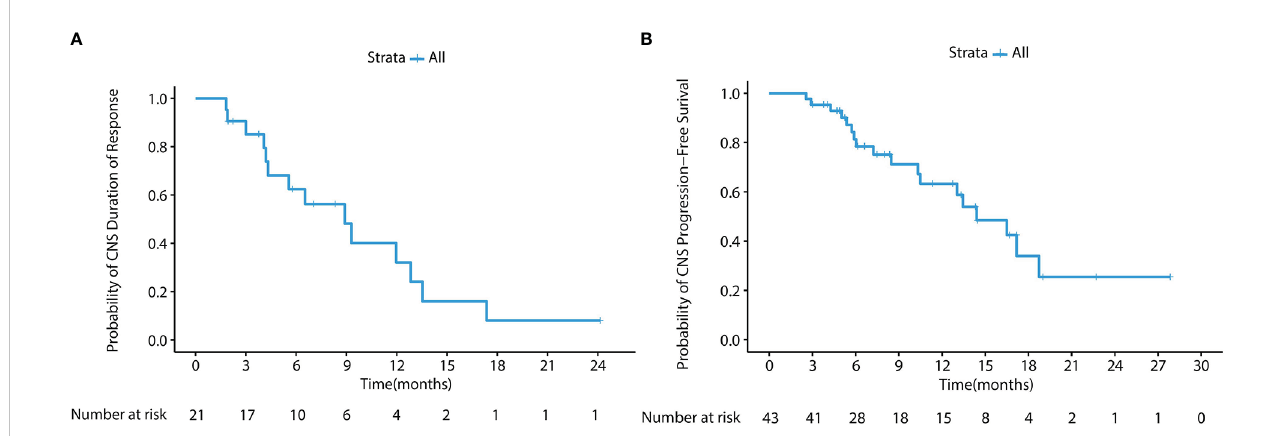
FIGURE 3 (A) Kaplan-Meier survival curve of CNS DoR in the cFAS set. The CNS mDoR was 8.9 months (95% CI, 4.7 - 13.1 months). (B) Kaplan-Meier survival curve of CNS PFS in the cFAS set. The CNS mPFS was 12.7 months (95% CI, 6.9 - 18.5